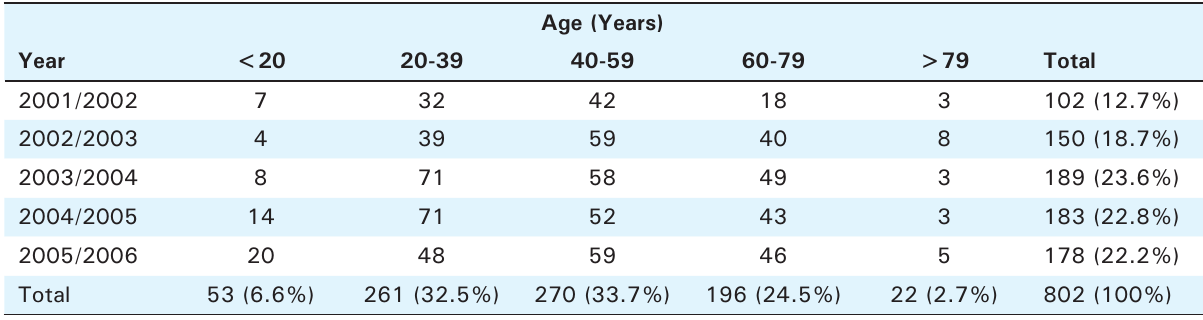
Table 2. Aetiology of ESRD within different age groups (Years) Diagnosis